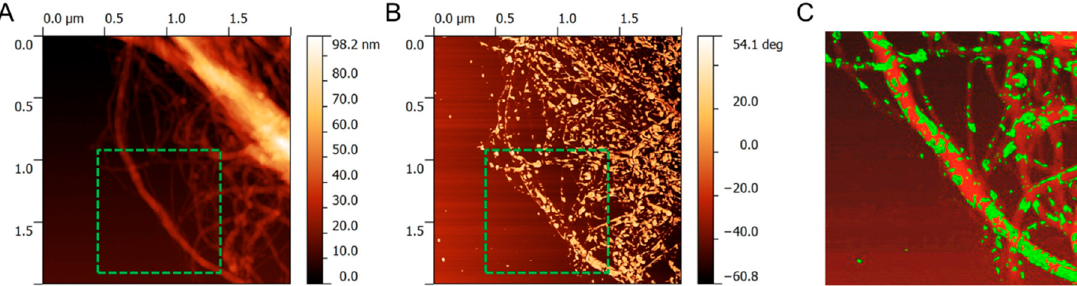
Figure 2. Atomic force microscopy (AFM) images of MFLC. ( A ) Height image, ( B ) phase image, ( C ) superimposed and digitally enhanced image of regions marked with a green dash square in the height and phase images. In image ( C ), red signal corresponds to height and green signal corresponds to phase.